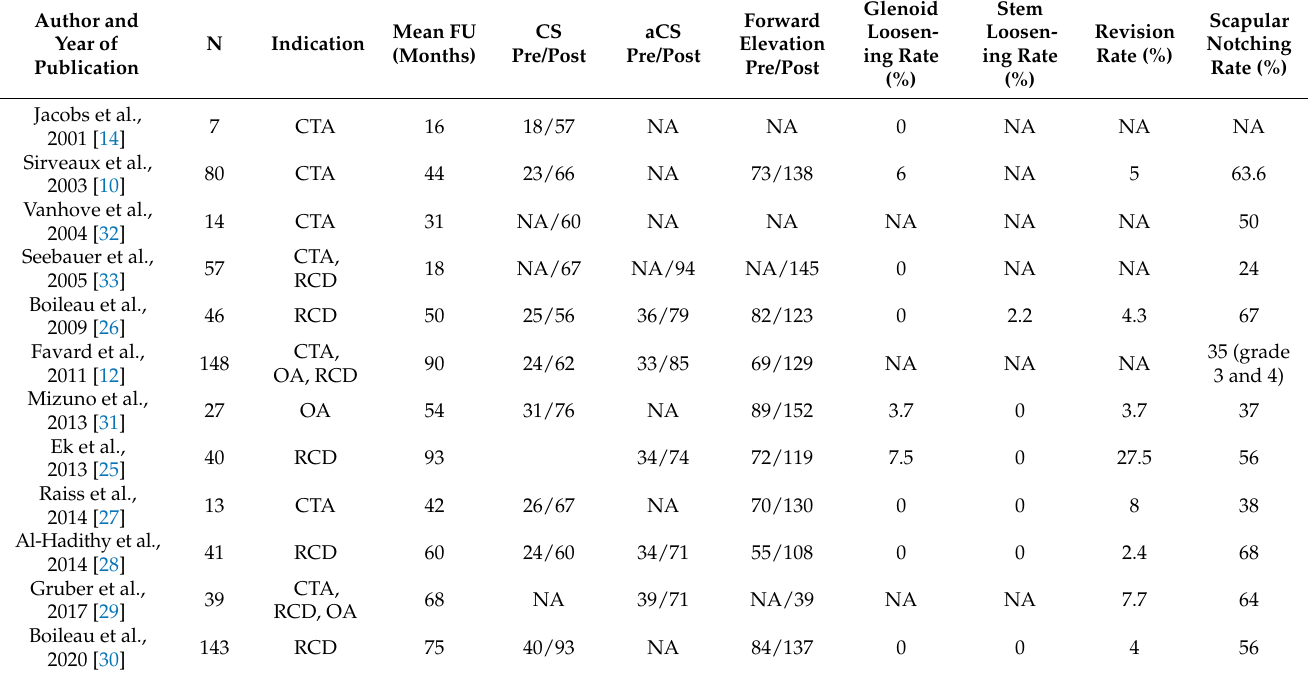
Table 5. Overview of recent literature on clinical outcome data. CTA = cuff tear arthropathy; RCD = rotator cuff deficiency; OA = primary